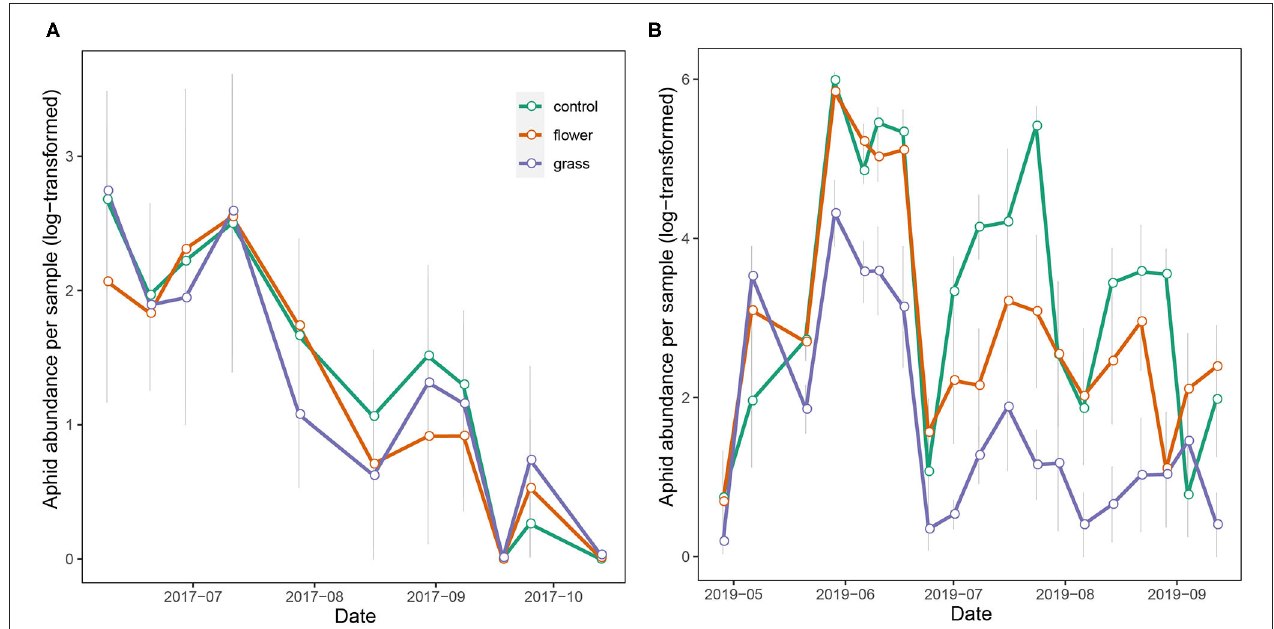
FIGURE 5 | Temporal abundance of aphid (mean ± SE) in the treatments of the apple trees during 2017 (A) and 2019 (B)